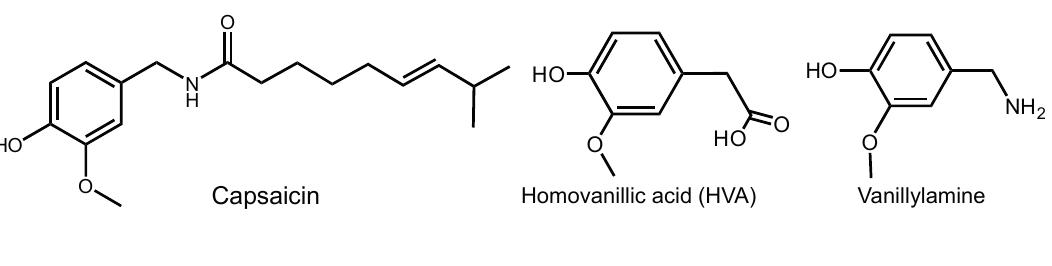
Figure 8. Structural formulae of capsaicin, homovanillic acid and vanillylamine.